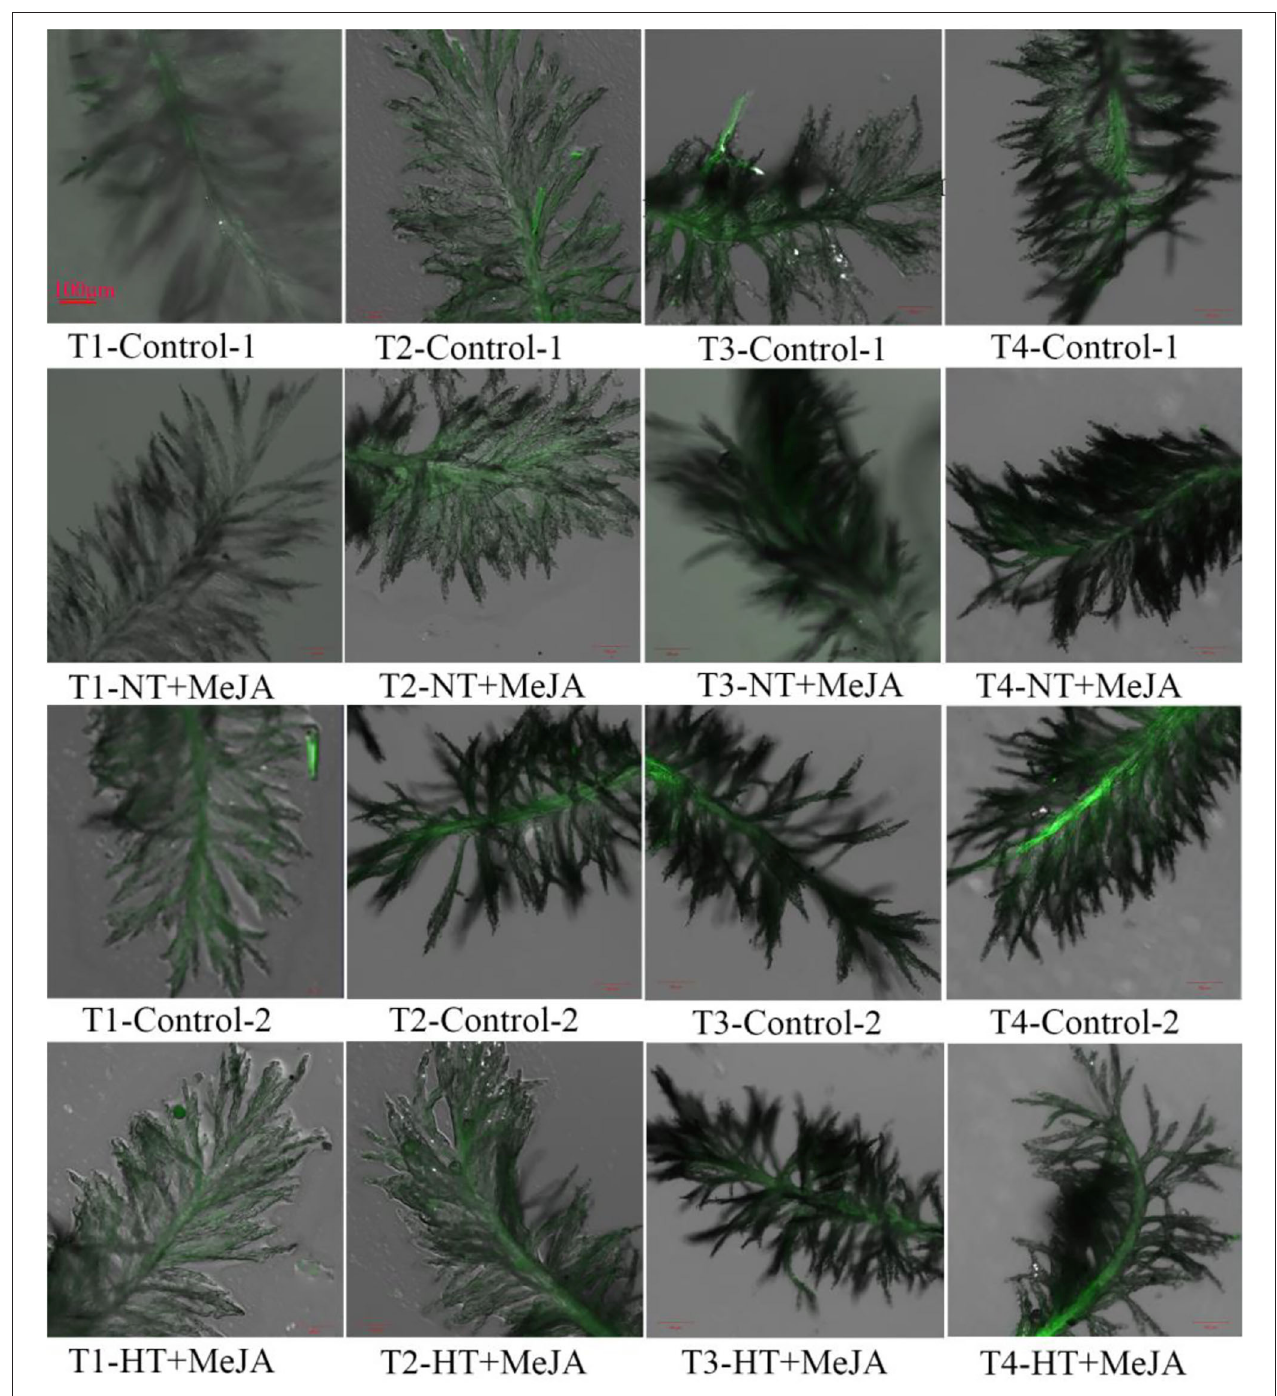
FIGURE 5 | Effect of MeJA application on the accumulation of reactive oxygen species (ROS) in stigmas of Shen 08S subjected to high-temperature stress during anthesis. Control-1 and Control-2 indicate spraying water under normal temperature (NT) and spraying water under high temperature (HT), respectively. NT + MeJA and HT + MeJA represent spraying MeJA under NT and spraying MeJA under HT, respectively. T1: 12:00h on the first day during the temperature treatment; T2: 14:00h on the first day during the temperature treatment; T3: 14:00h on the second day during the temperature treatment; T4: 14:00h on the first day after the temperature treatment. Black unstained stigmas indicate an absence of ROS, and green-stained stigmas indicate the presence of ROS. The intensity of the green color is proportional to the ROS level. The stigmas were stained with the LIVE Green ROS detection kit and were taken at 60 × magnifications.